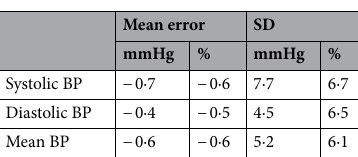
Table 5. Overall performance of OptiBP compared to dual-head stethoscope cuff